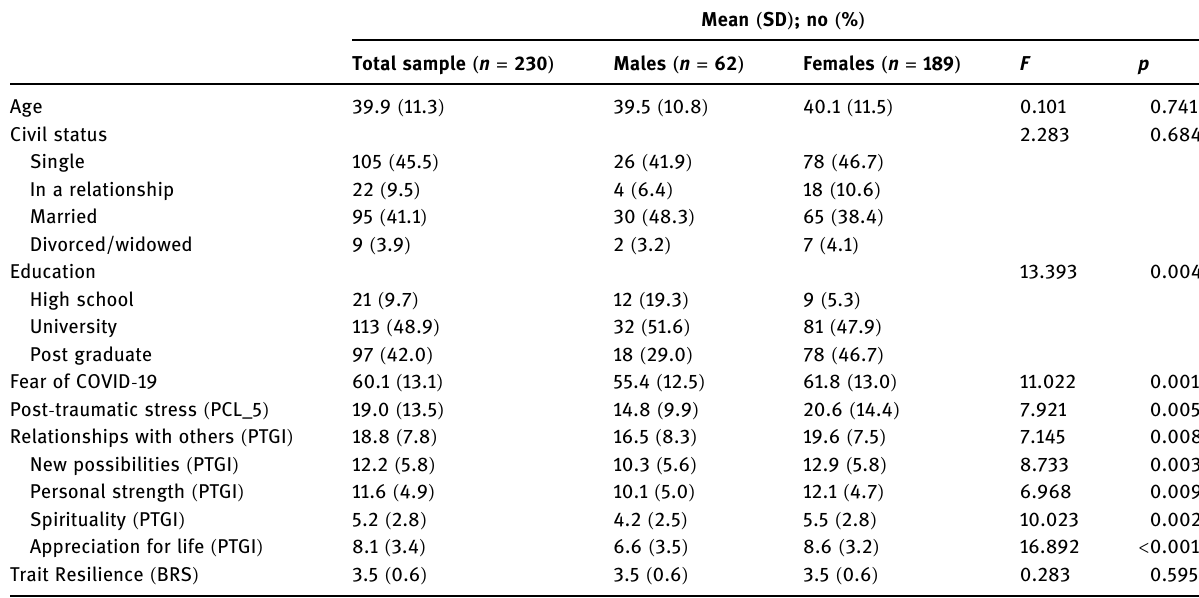
Table 1: Sociodemographic and clinical characteristics of the sample